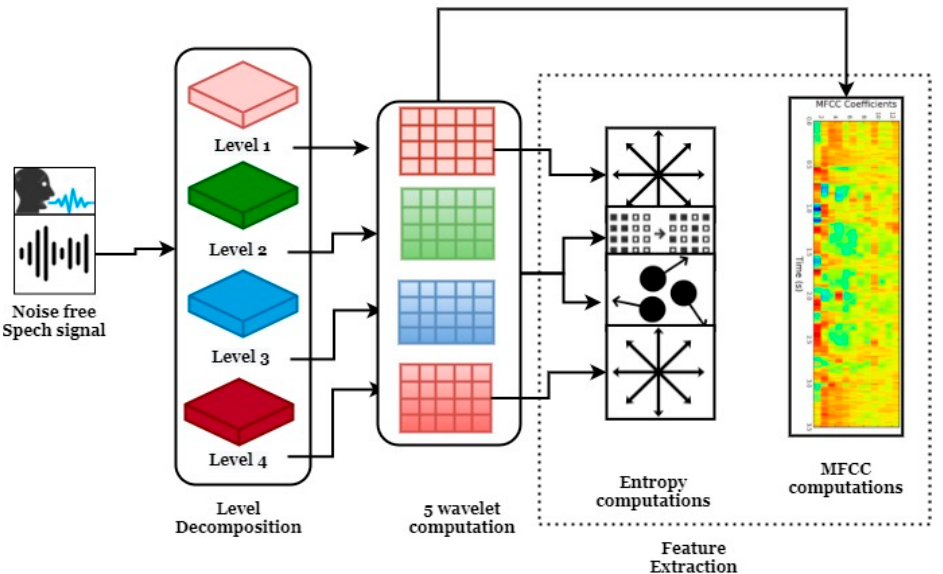
Figure 3. Feature extraction using level decomposition, wavelet computation, entropy calculation, and MFCC coefficient computation.